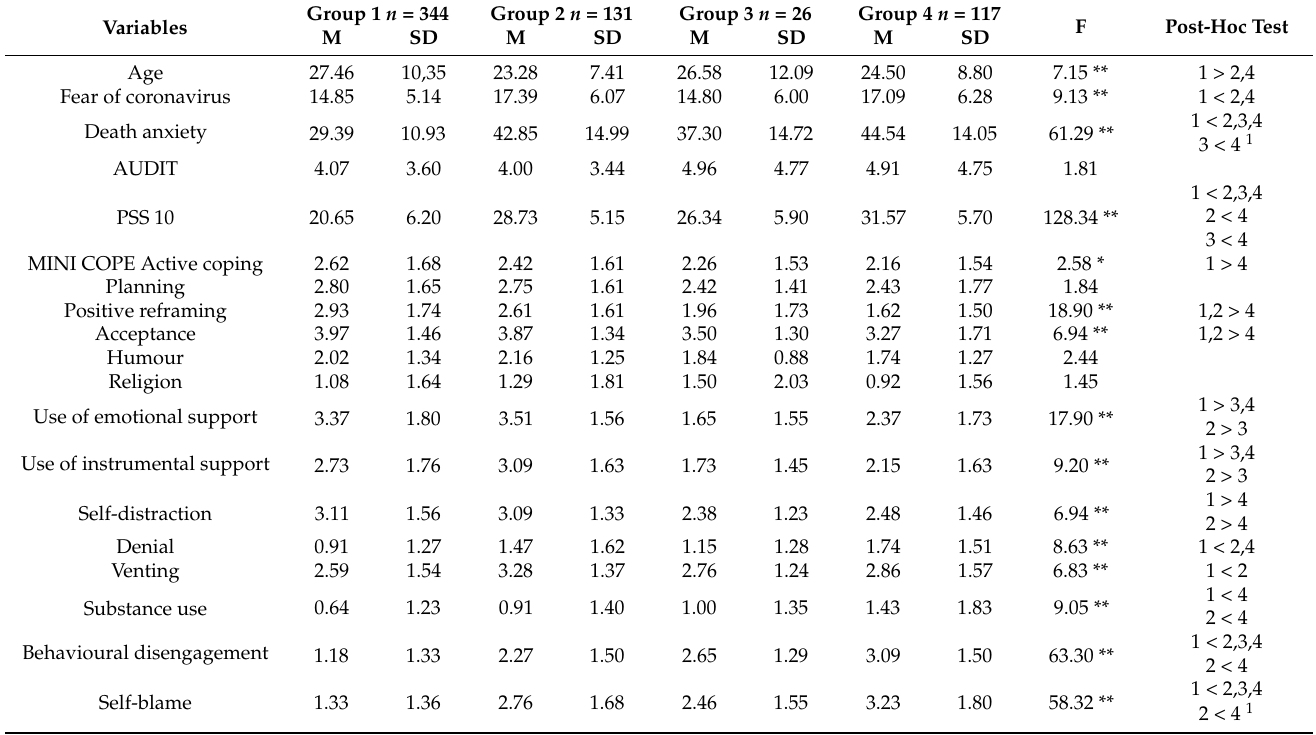
Table 6. Comparison of